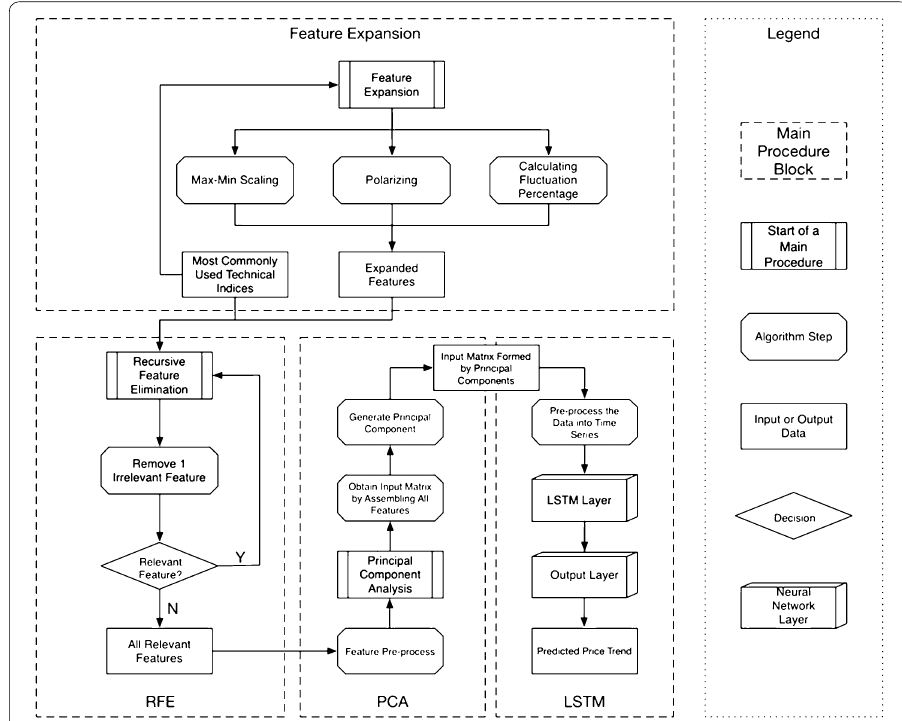
Fig. 3 Detailed technical design of the proposed